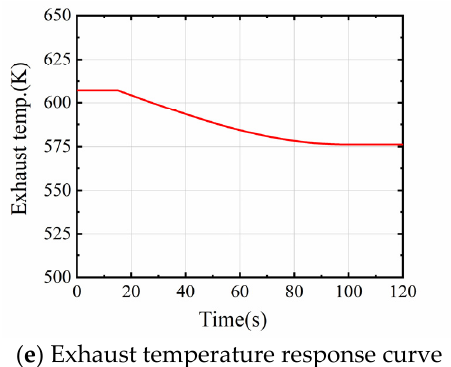
Figure 9. The response curve of engine performance parameter.